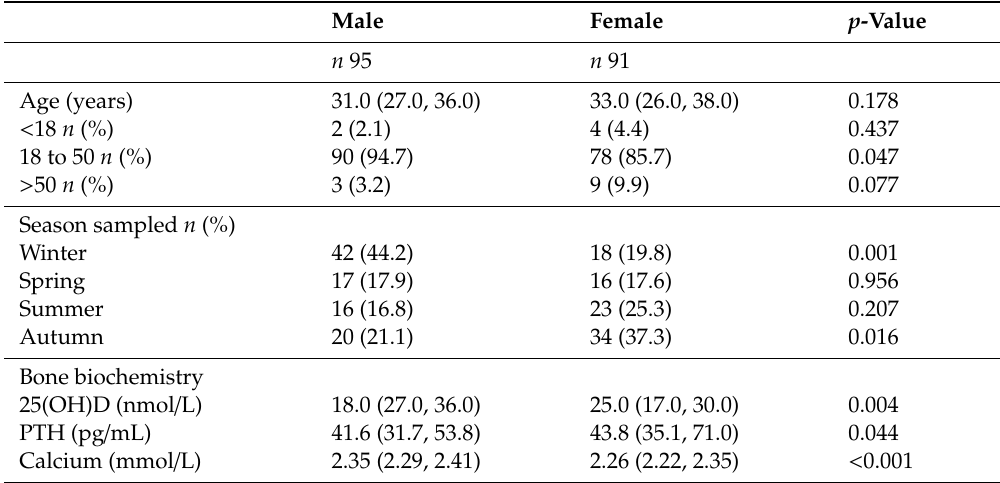
Table 1. Population characteristics of the South East Asian participants 1